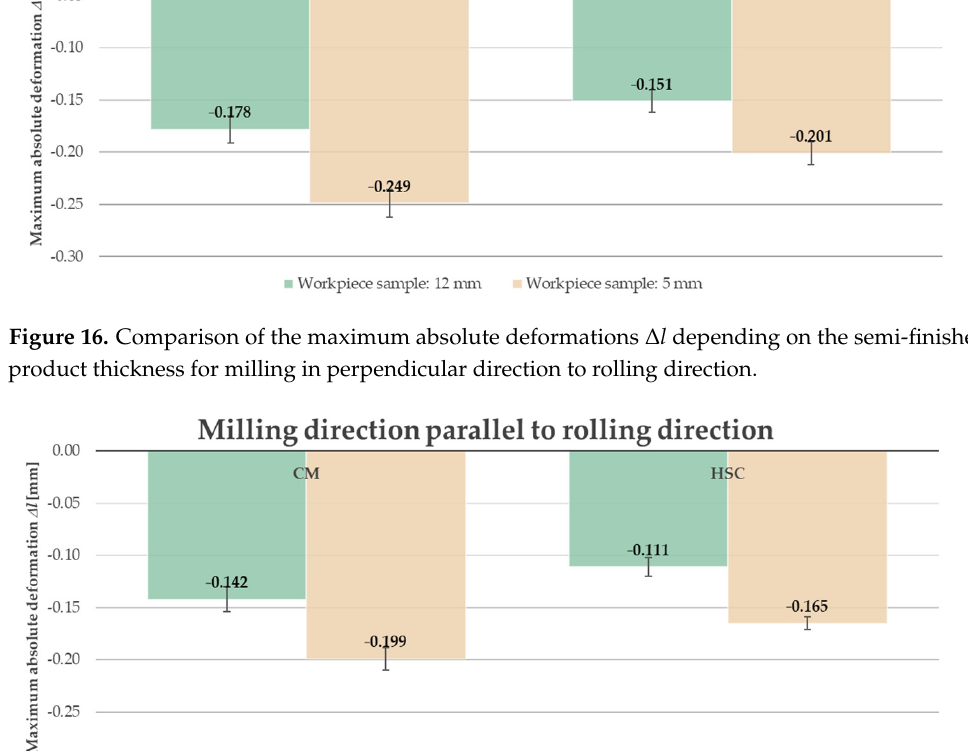
Figure 17. Comparison of the maximum absolute deformations ∆ l depending on the semi-finished product thickness for milling in parallel direction to rolling direction.